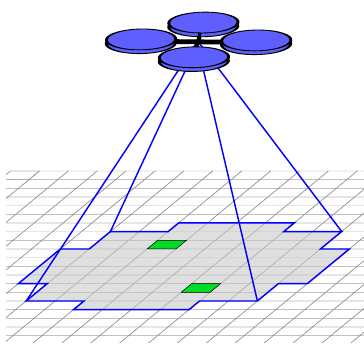
Figure 7. Sensor model for downward facing camera. Green/dark squares indicate cells containing detected targets, while grey squares indicate cells that are within the field of view with no target detections. Targets are not